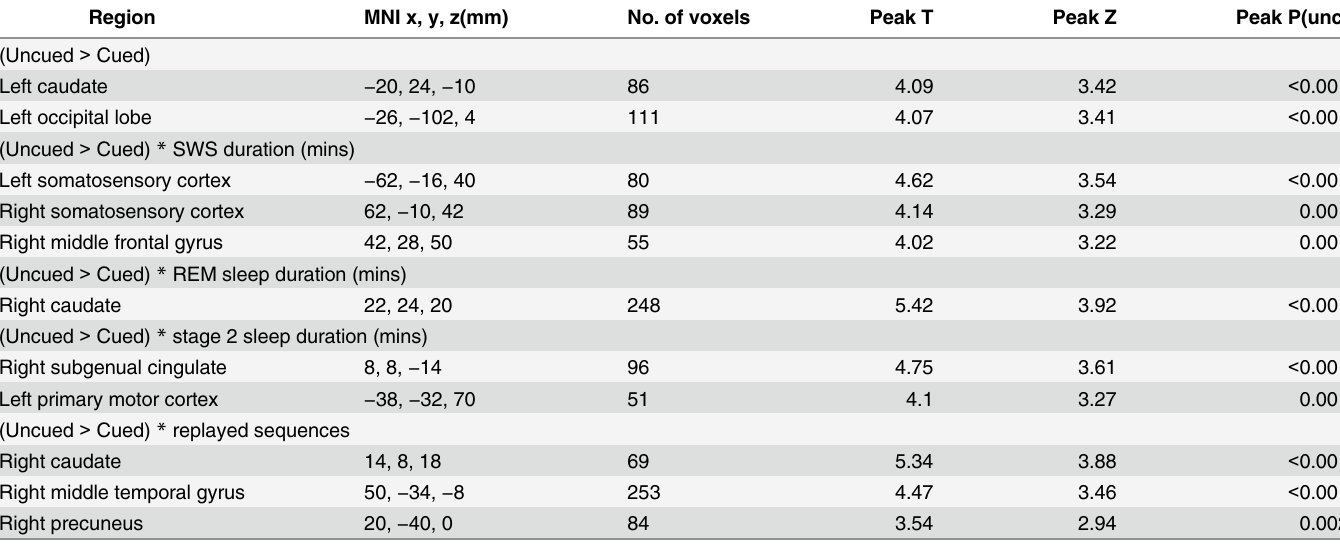
The main effect of TMR across the whole brain, showing decreased activity that was associated with SWS duration, REM sleep duration, stage 2 sleep duration, replays, and the procedural cueing effect, voxel threshold of p = 0.05 (whole brain corrected) and extent threshold of k > 50 voxels. All active voxels are positive for the uncued > cued comparison. There were no signi fi cant decreases associated with the procedural cueing